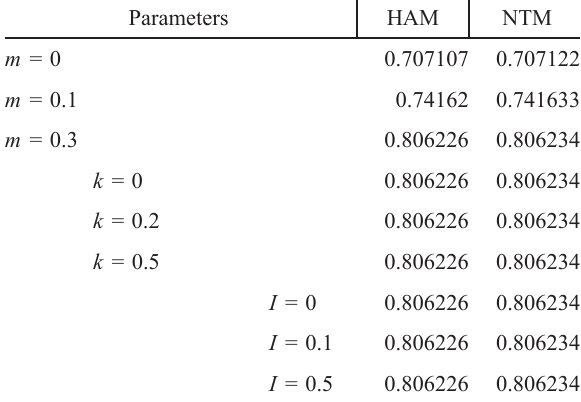
Table 5 – Effect of parameters on Nusselt number, (Re) –1/2 Nu Parameters